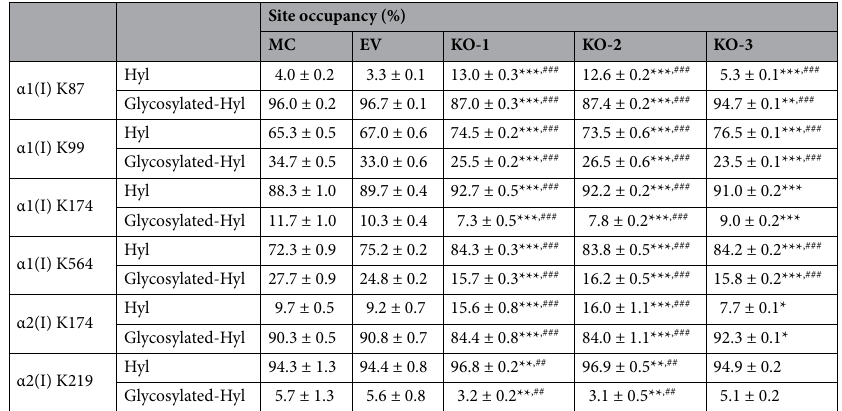
Table 4. Glycosylation of hydroxylysine residues estimated by mass spectrometry of non-cross-linked glycosylated residues. Glycosylation of Hyl residues (%) represents the relative levels of Glycosylated Hyl (G-Hyl + GG-Hyl). Hyl + Glycosylated Hyl = 100%. Values represent mean ± S.D. (n = 3) of triplicate analysis for each group. Statistical differences were determined by Kruskal–Wallis one-way analysis of variance and means comparison with the controls by Dunnett’s method. Hyl hydroxylysine, G- galactosyl-, GG- glucosylgalactosyl-, MC MC3T3-E1, EV empty vector, KO knock-out. * p < 0.05, ** p < 0.01, and *** p < 0.001 between MC and KO; ## p < 0.01 and ### p < 0.001 between EV and KO, respectively.